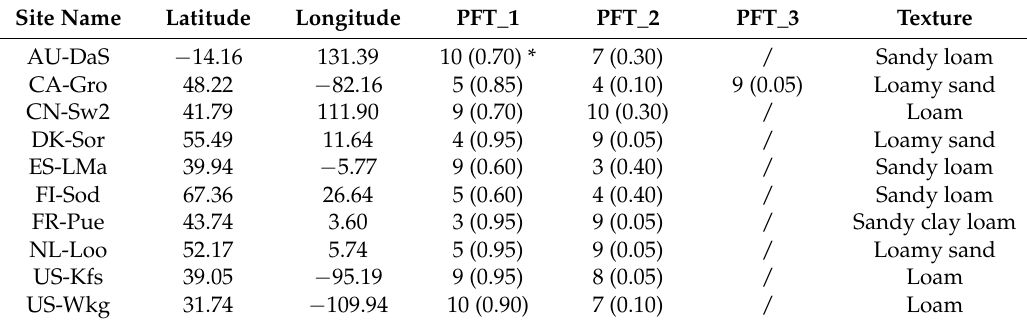
Table 1. Study site information, including latitude, longitude, PFTs, and